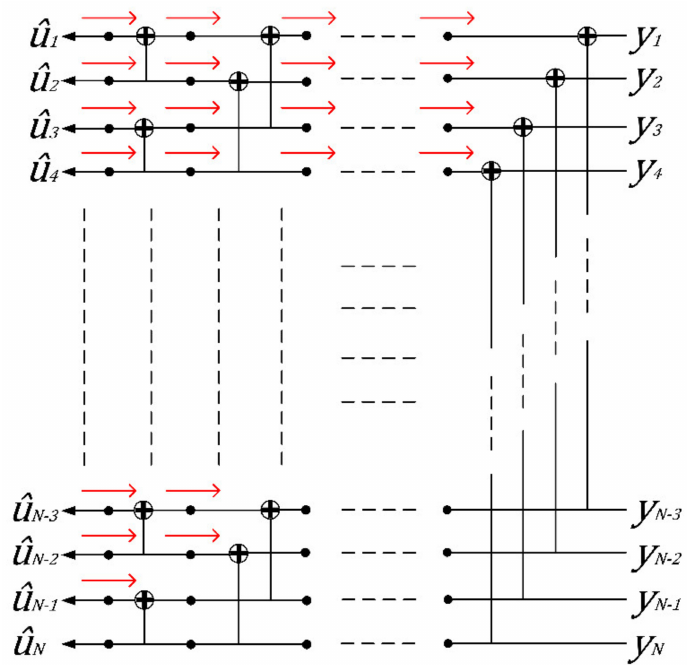
Figure 1. Successive cancellation decoding.